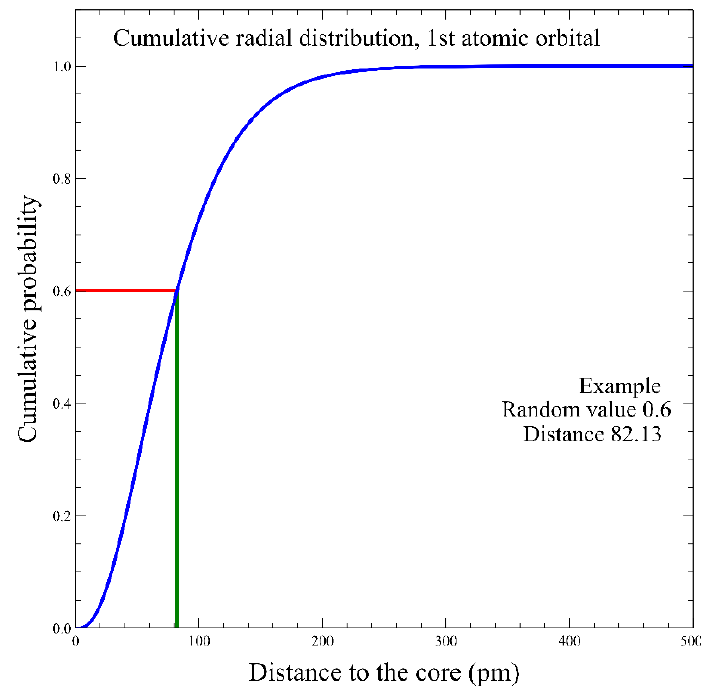
Figure 4. Sampling example.